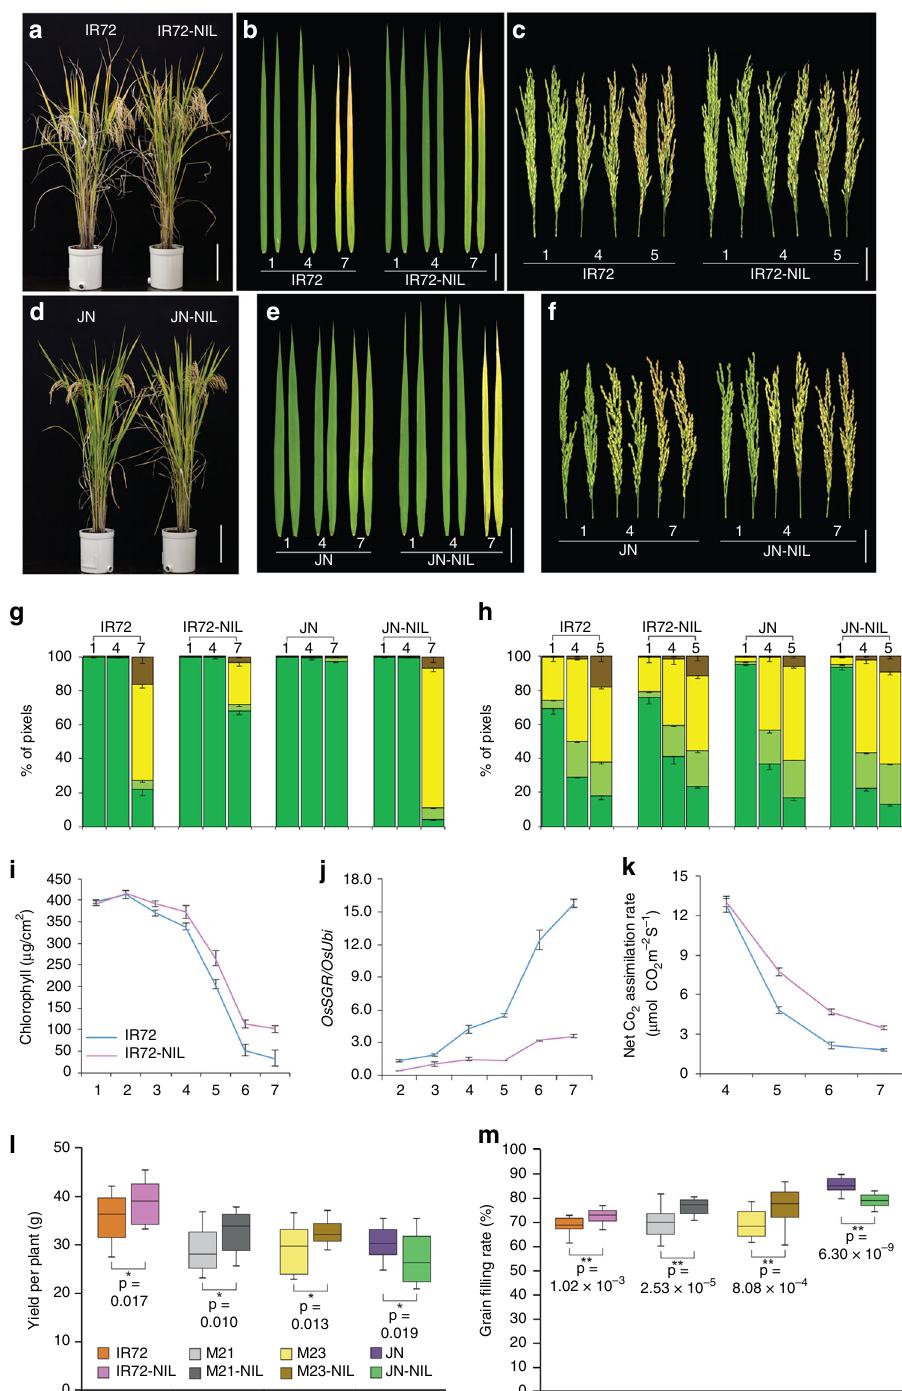
Fig. 4 The japonica allele of OsSGR increases grain fi lling and yield when introgressed into elite indica cultivars. a Whole-plant senescence phenotypes of an indica- type cultivar (IR72) and its near isogenic line (IR72-NIL) harboring the japonica OsSGR allele grown in paddy fi eld. Scale bar, 20 cm. Color changes of the fl ag leaves ( b ) and panicles ( c ) from plants in ( a ) during seasonal senescence (1, 4, and 7 weeks after heading). Scale bar, 5 cm. In colourimetric assay, the same scale is used as in Fig. 1. d Senescence phenotype of a japonica cultivar (JN) and its near isogenic line (JN-NIL) harboring the indica OsSGR allele. Scale bar, 20 cm. Color changes of the fl ag leaves ( e ) and panicles ( f ) from plants in ( d ). Quanti fi cation of leaf color change in the fl ag leaves ( g ) and panicles ( h ). Data are means± SE ( n ≥ 4). i Temporal changes of chlorophyll levels of fl ag leaves from 1 to 7 weeks after heading. Data are means ± SE ( n = 8). j Analysis of OsSGR expression in the fl ag leaves from plants in ( a , d ) from 2 to 7 weeks after heading. Data are means ± SE ( n = 3). k The analysis of the net CO 2 assimilation rate in fl ag leaves of IR72 and IR72-NIL during the grain- fi lling stage (4, 5, 6, and 7 weeks after heading). Data are means ± SE ( n = 5). Total grain yields per plant ( l ) and grain- fi lling rates ( m ) of the near isogenic lines (NIL). In the box plots, the center value is the median, and the bottom and top edges of the boxes display 1.5 times the interquartile range. Values are the mean ± SE ( n ≥ 16). * P < 0.05, ** P < 0.01 by Student ’ s t test. Source data of Fig. 4g – m are provided as a Source Data fi